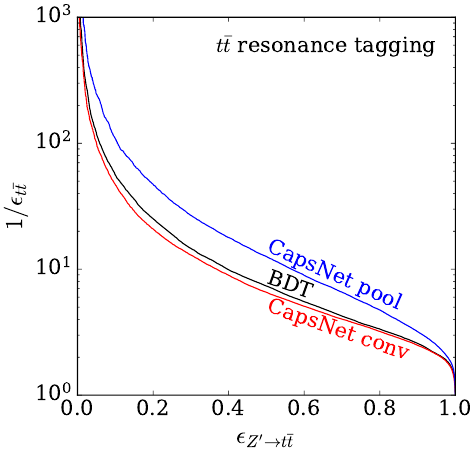
Figure 7: ROC curves for two capsule networks and the BDT benchmark, trained and tested on Z (cid:48) ( → t ¯ t ) signal and continuum t ¯ t background